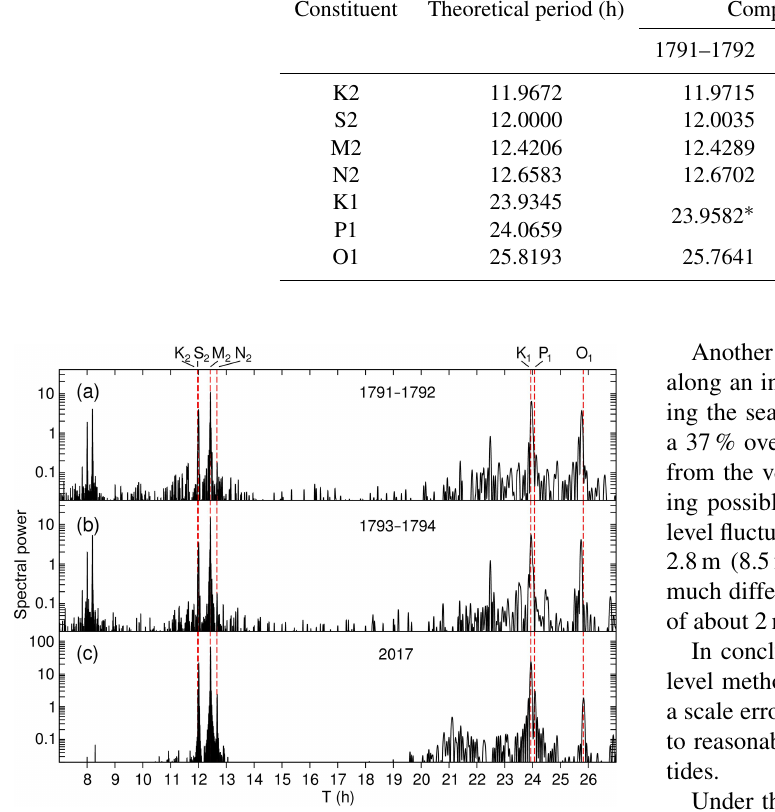
Figure 5. Normalized spectrograms obtained from the periodogram analysis of the 1791–1792 (a) , 1793–1794 (b) and 2017 (c) data. The period interval ( T for time) between 7 and 27h is shown. The seven main tidal constituents are identified on top, and their the- oretical periods (Table 1) are indicated by the vertical red dashed